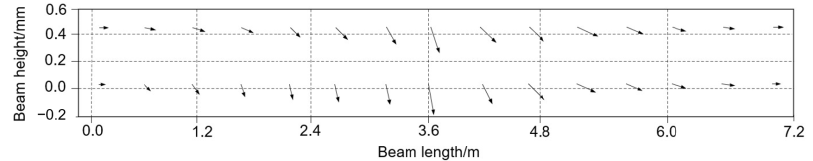
Figure 22. Code-mark displacement calculation results. The displacement vector near the code marks was compared with that shown in Figure 22, based on the D01 400 kN condition (see Figure